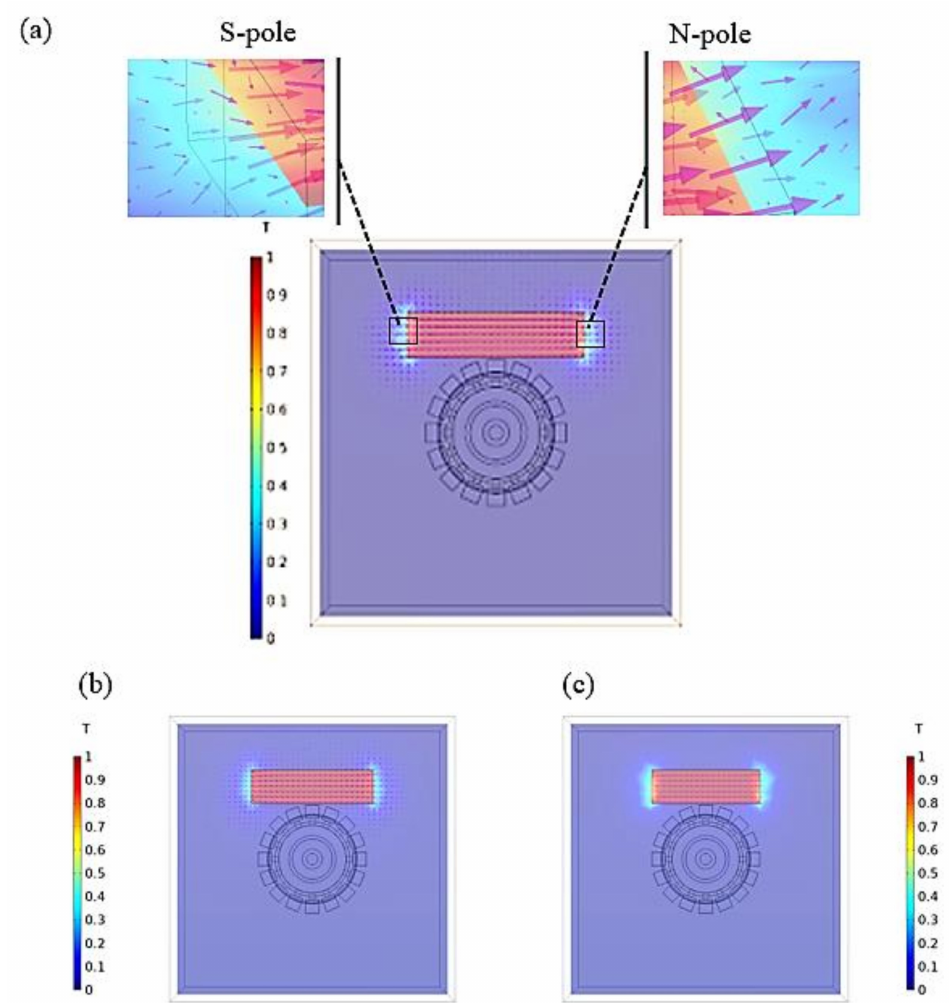
Figure 11. Simulation results of different models of thermomagnetic engine: ( a ) magnetic flux distribution of 100 mm magnet, ( b ) magnetic flux distribution of 90 mm magnet, ( c ) magnetic flux distribution of 80 mm